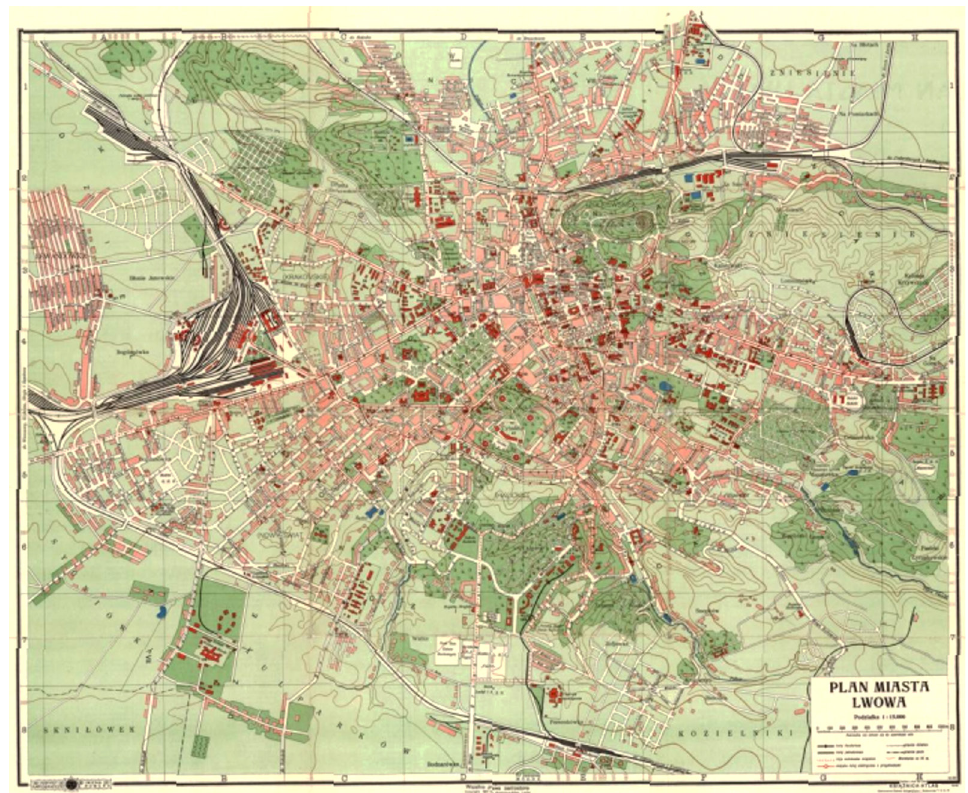
Fig. 2. Map of the City of Lviv, 1932, Cartographic Institute of E. Romer, Książnica Atlas, Zjednoczone Zakłady Kartograficzne i Wydawnicze TNSW